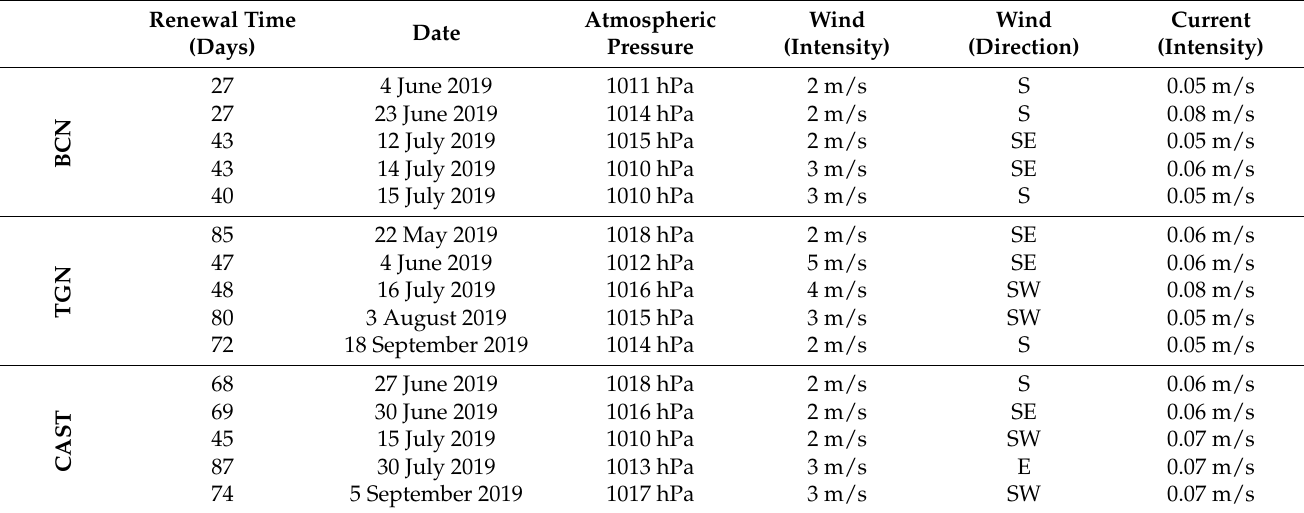
Table 8. Main meteocean drivers represented by atmospheric pressure and wind intensity, together with the resulting current velocity (daily averages) during the days that featured the highest renewal times in each